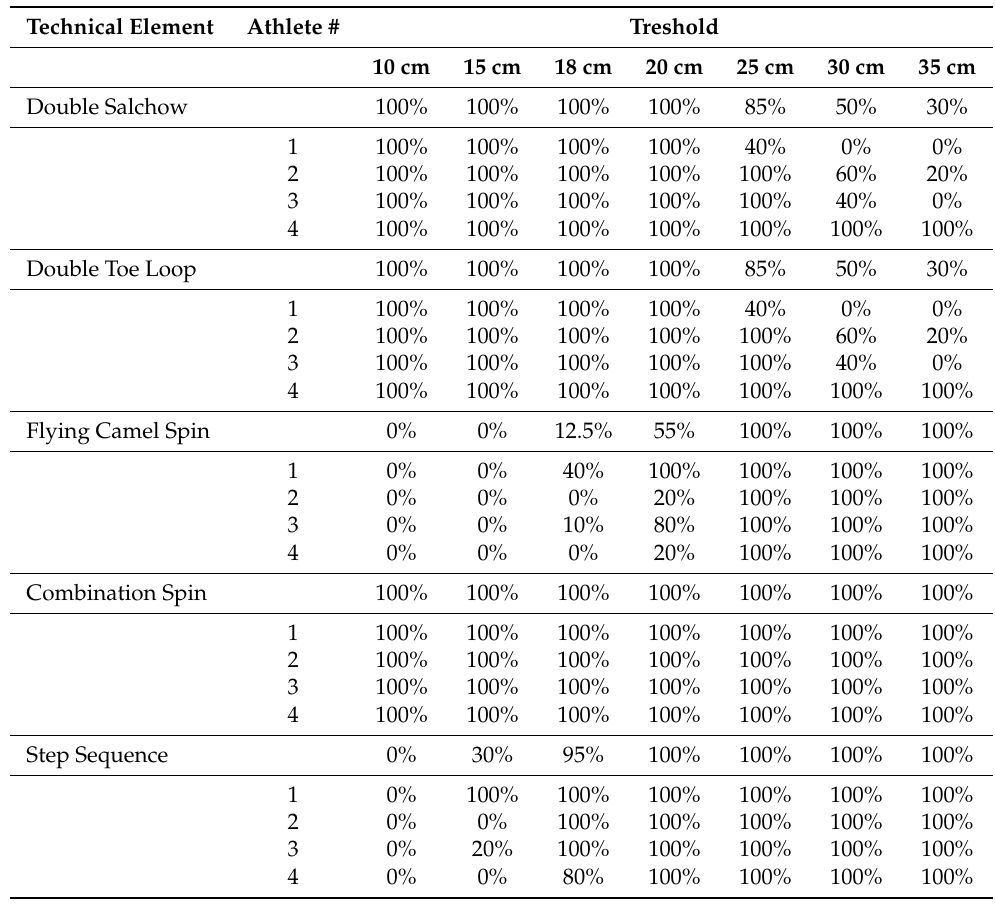
Table 5. The accuracy of the detection of different technical elements for multiple thresholds and for each athlete. The thresholds played a significant role in delivering optimal accuracy and were essentially dependent on the characteristics of each athlete, such as height, weight and